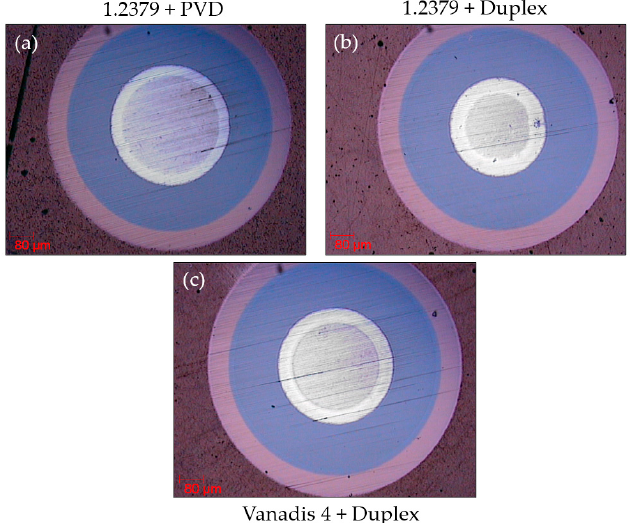
Figure 1. Glow discharge optical spectrometry (GD-OES) concentration profiles in the 1.2379 + PVD ( a ), 1.2379 + Duplex ( b ), and Vanadis 4 + Duplex ( c ) samples.